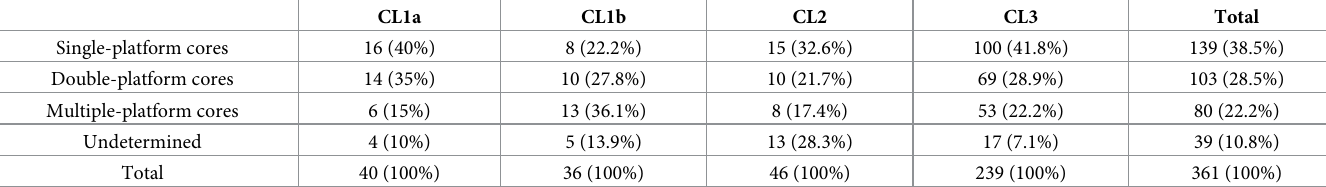
Table 8. Core categories by platform over